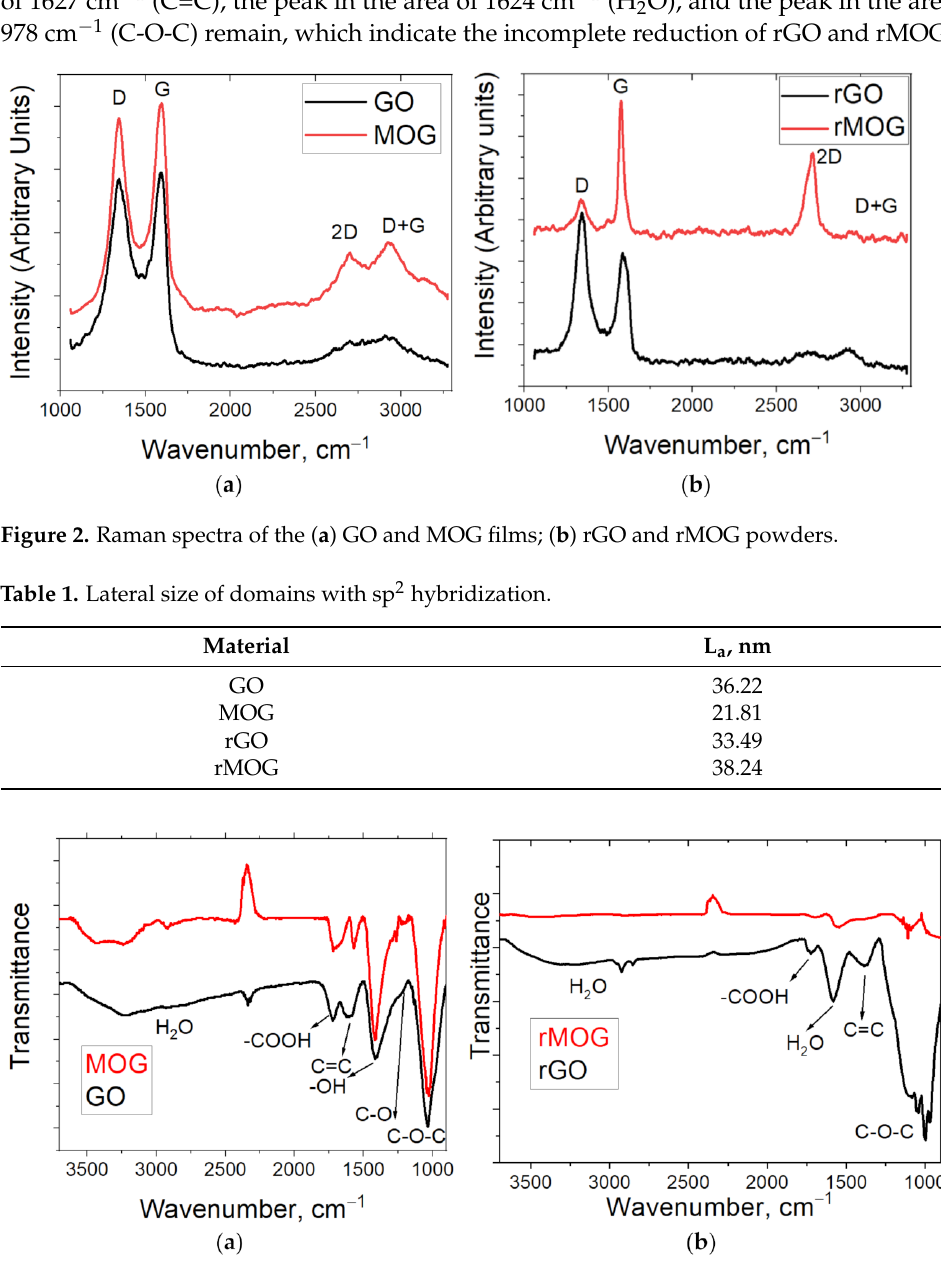
Figure 3. IR spectra of ( a ) GO and MOG films; ( b ) rGO and rMOG